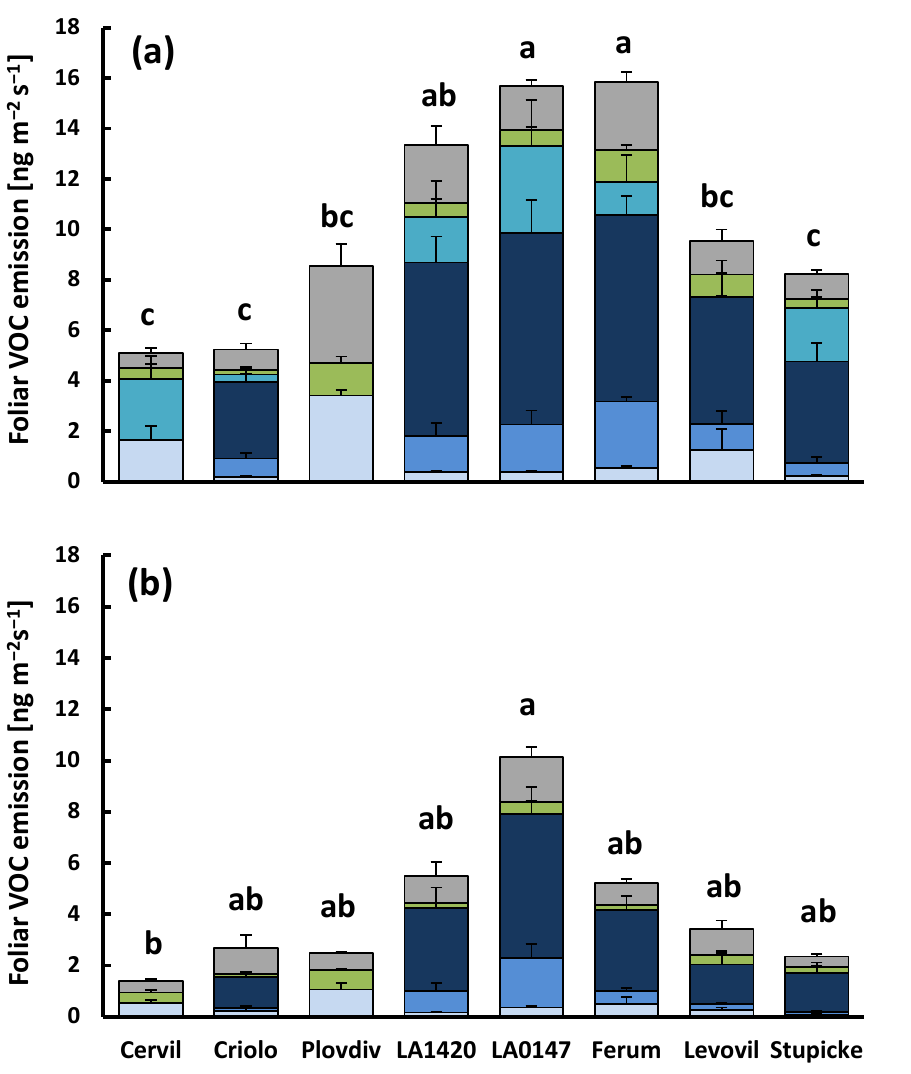
Figure 1. Foliar Volatile Organic Compounds (VOC) emissions of the eight accessions of the MAGIC tomato population under light ( a ) and dark conditions ( b ). Cervil, Criolo, Plovdiv24A (referred to as Plovdiv) and LA1420 belong to the Solanum lycopersicum cerasiforme group with cherry-type fruits, while LA0147, Ferum, Levovil and Stupicke Polni Rane (referred to as Stupicke) belong to the Solanum lycopersicum lycopersicum group with large fruits. Column sections show the mean emissions + SE ( n = 4–6) of the five major emitted compounds and the sum of all other compounds. Superscript letters denote significant differences ( p < 0.05) between genotypes for the sum of VOC emissions based on Bonferroni tests following an ANOVA ( p < 0.001) and Dunn’s test following a Kruskal–Wallis test ( p = 0.022) for light and dark VOC emissions, respectively (see supplementary material Table S2 for more details).